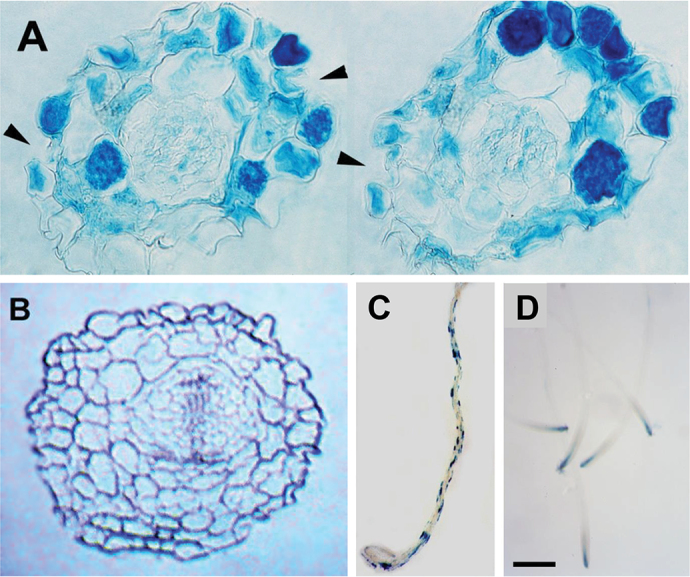
The hlq mutant has ectopic expression of the proDc3:GUS reporter gene. (A) Cross-section through the hypocotyl of 2-week-old hlq and parental-type (B) plants, stained for GUS. Parental-type plants do not stain for GUS after 10 d. hlq shows ectopic staining not only in the epidermal cells but also in the cortex. The arrows indicate collapsed cells in the epidermal cell file, and the cell shapes are also irregular. (C) Ectopic expression of proDc3:GUS in a 7-day-old hlq mutant primary root. (D) Wild-type expression of proDc3:GUS. Scale bar=500 μm.